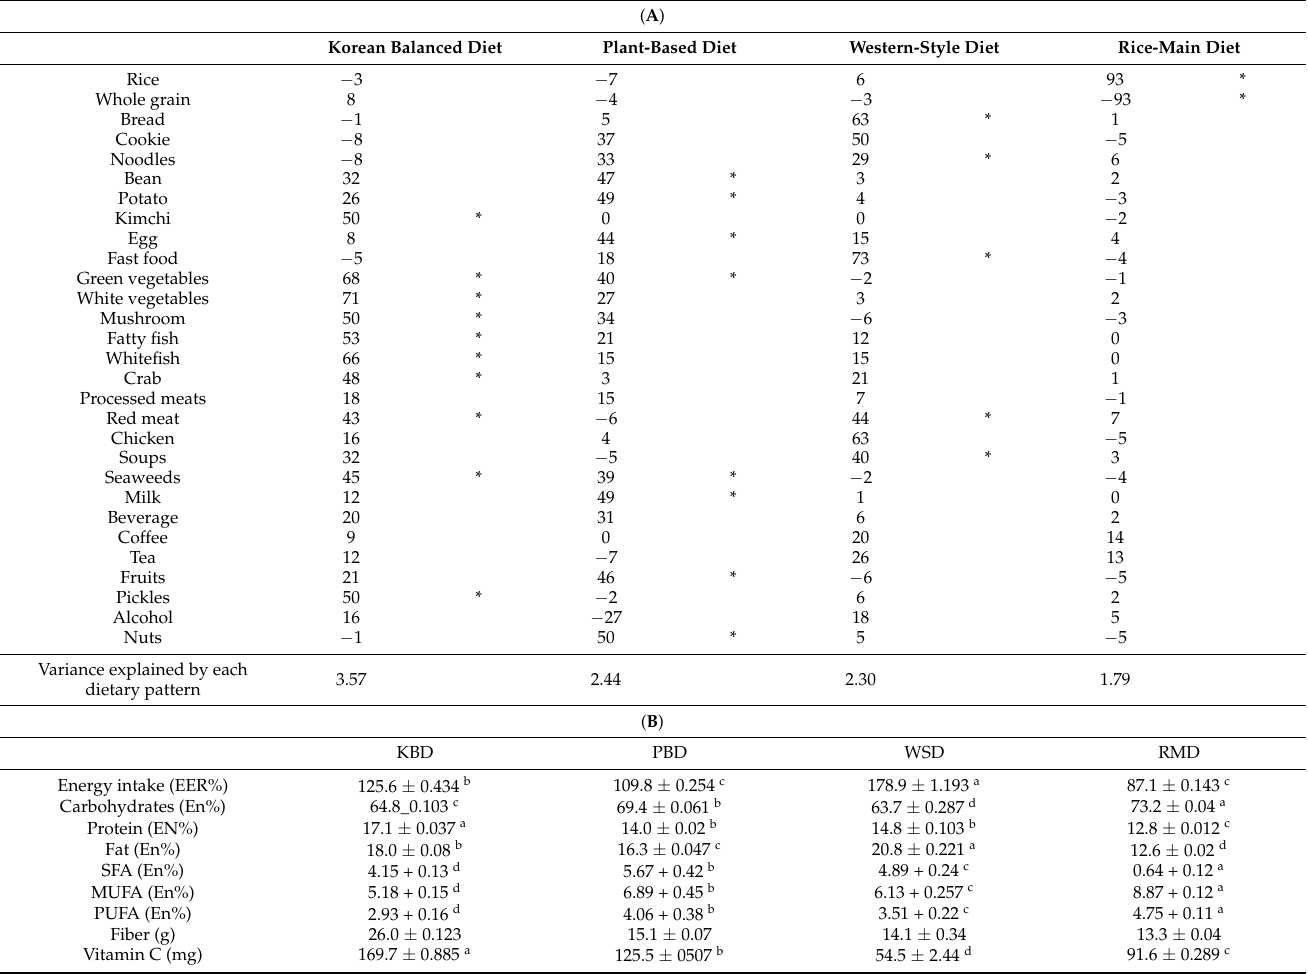
Table 1. ( A ) The factor-loading values of the predefined 29 food groups in each dietary pattern. ( B ) Energy intake in each dietary pattern. ( A ) Korean Balanced Diet Plant-Based Diet Western-Style Diet Rice-Main Diet